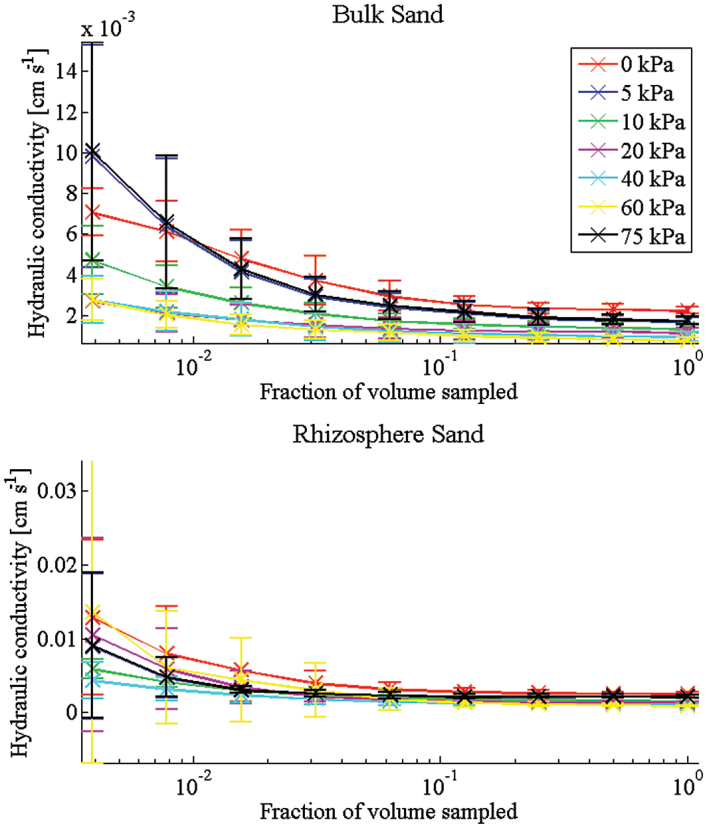
Convergence plots for sand soil. For each case (rhizosphere and bulk), three samples were taken. From each of these, six subsamples were obtained. These plots show the average and standard deviation over the 18 subsamples for increasing subsample size. (This figure is available in colour at JXB online.)